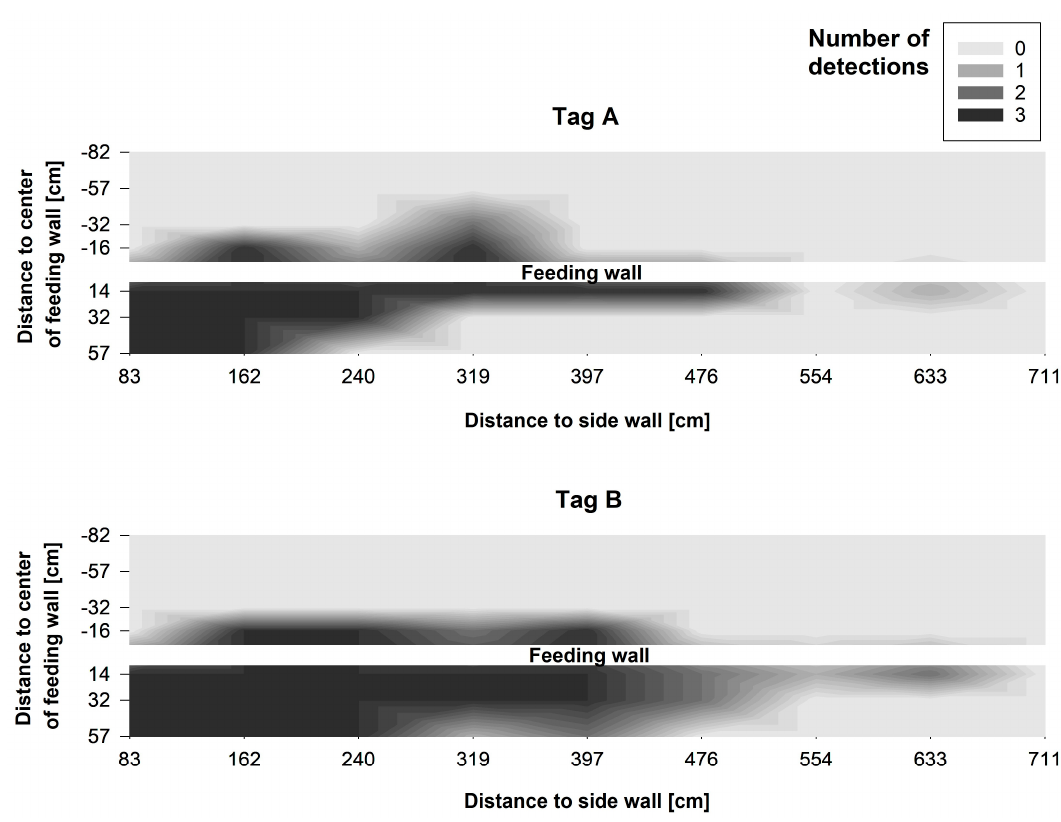
Figure 8. Interpolated contour plot showing the number of successful detections per coordinate for both types of UHF ear tag at a height of 55 cm and for Antenna Position 2. Major ticks on the x- and y-axes indicate the measurement coordinates. Each x-coordinate represents the centre of a feeding place along the feed fence.